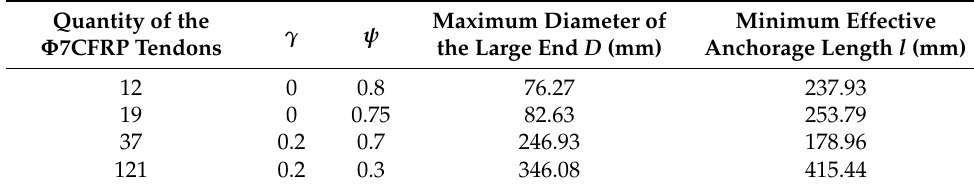
Table 1. Parameters of the anchorage devices.